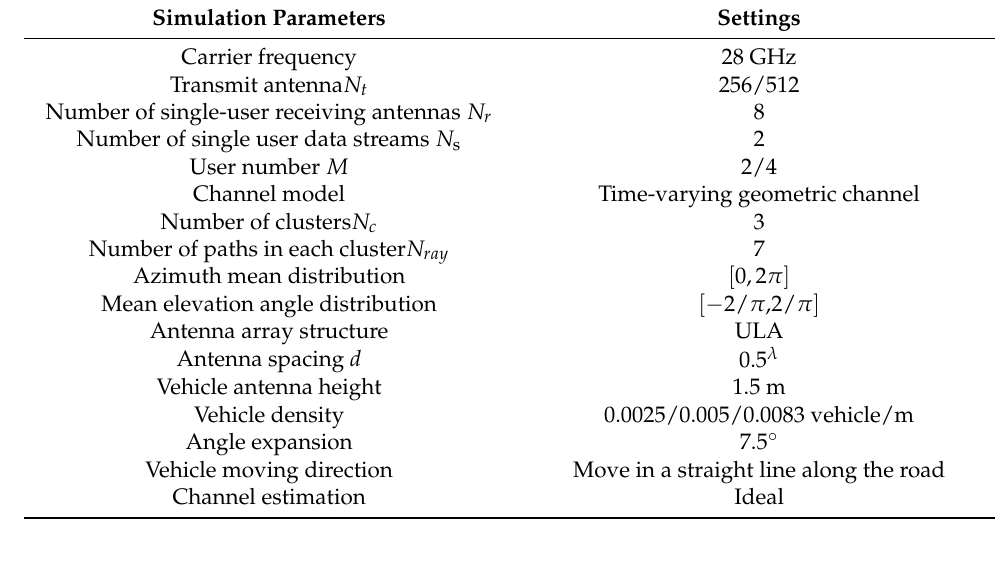
Table 4. Main parameter settings of the system simulation.